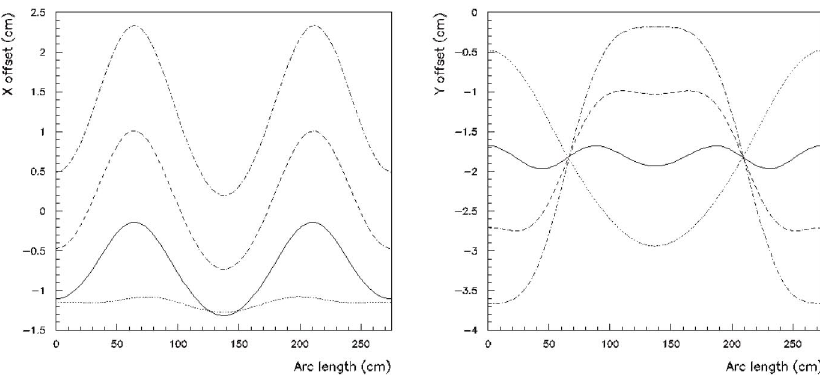
FIG. 8. Closed orbits in a cell—deviations from the central line of the ring in the radial direction (left) and in the vertical direction (right). The different line types correspond to orbits of different momentum muons: solid is for 201 MeV =c (reference particle), dotted, dashed, and dot-dashed are for 170, 227, 248 MeV =c , respectively.